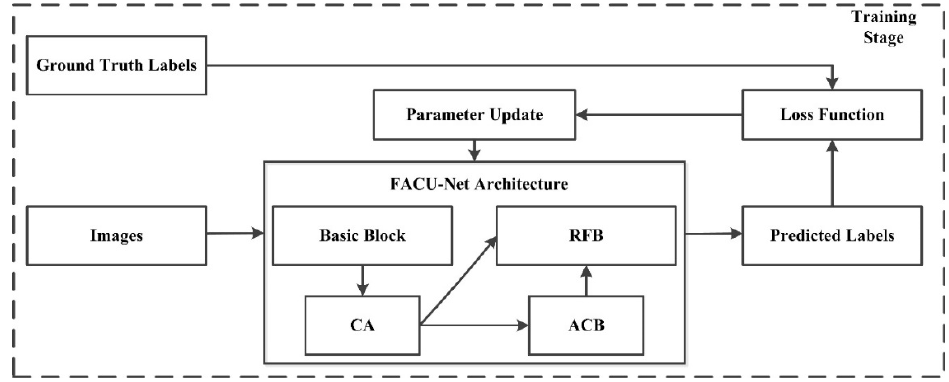
Figure 1. The framework of our proposed approach.